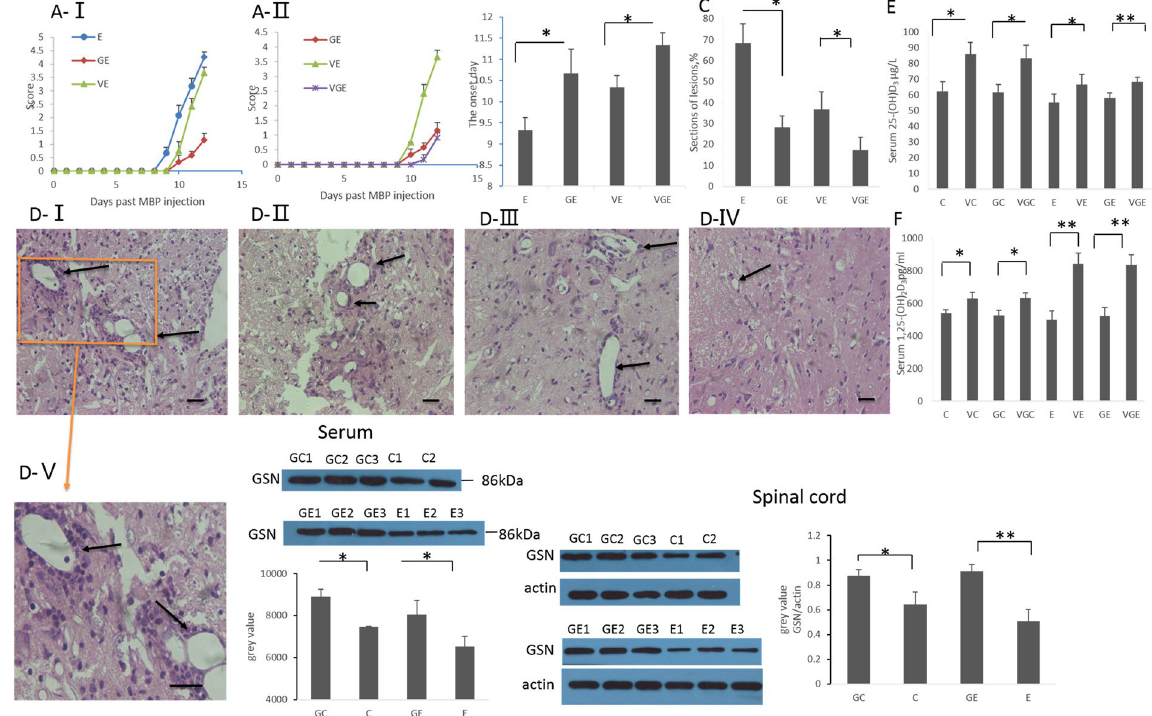
Figure 2. LV-GSN and vitamin D 3 supplementation delays the onset of EAE and reduces inflammation. ( A ) Effects of LV-GSN, vitamin D 3 and the combination of them on the course of EAE disease progression as evaluated by severity scoring. * p < 0.05. Shown is the composite mean from 17–18 mice/group evaluated in three separate experiments. ( B ) Average time of onset of EAE for rats fed with (VE) and without (E) vitamin D, injected with LV-GSN (GE), and injected with LV-GSN during vitamin D supplement (VGE) is shown. * p < 0.05. Shown is the composite mean from 17–18 mice/group evaluated in three separate experiments. ( C ) Statistical analysis of lesions in the spinal cord of E, GE, VE, and VGE rats. * p < 0.05. ( D ) Histopathological EAE disease in the spinal cord of E (D-I), VE (D-II), GE rats (D-III) and VGE rats (D-IV); D-Vis the higher magnification image of the marked part of D-I (representative images from 3 rats per group). The inflammatory lesions are indicated by arrows. (D-I, D-II, D-III, D-IV, × 200 magnification; D-V, × 400 magnification, scale bar 10 μ m). ( E ) The concentration of 25-(OH) D 3 in serum was measured by ELISA for rats fed without and with vitamin D supplementation in the control (C and VC), acute stage EAE (E and VE), and accompanied by LV-GSN (GE and VGE, GC, and VGC) groups. ** p < 0.01, * p < 0.05. ( F ) ELISA was performed to measure the concentration of 1,25-(OH) 2 D 3 in the serum of the same groups of rats as in panel E. ** p < 0.01, * p < 0.05. ( G ) Western blot and real-time PCR was performed to detect the efficiency of LV-GSN in increasing the expression of GSN in serum. ( H ) The change of GSN level (protein and mRNA) in the spinal cord before ( E ) and after (GE) LV-GSN injection, * p < 0.05 Data are mean ± SD. ** p < 0.01, * p < 0.05 (one-way ANOVA). The blots shown in Fig. 2G-I and 2H-I are cropped; the uncropped full-length gels are presented in the Supplementary Figure (Fig.